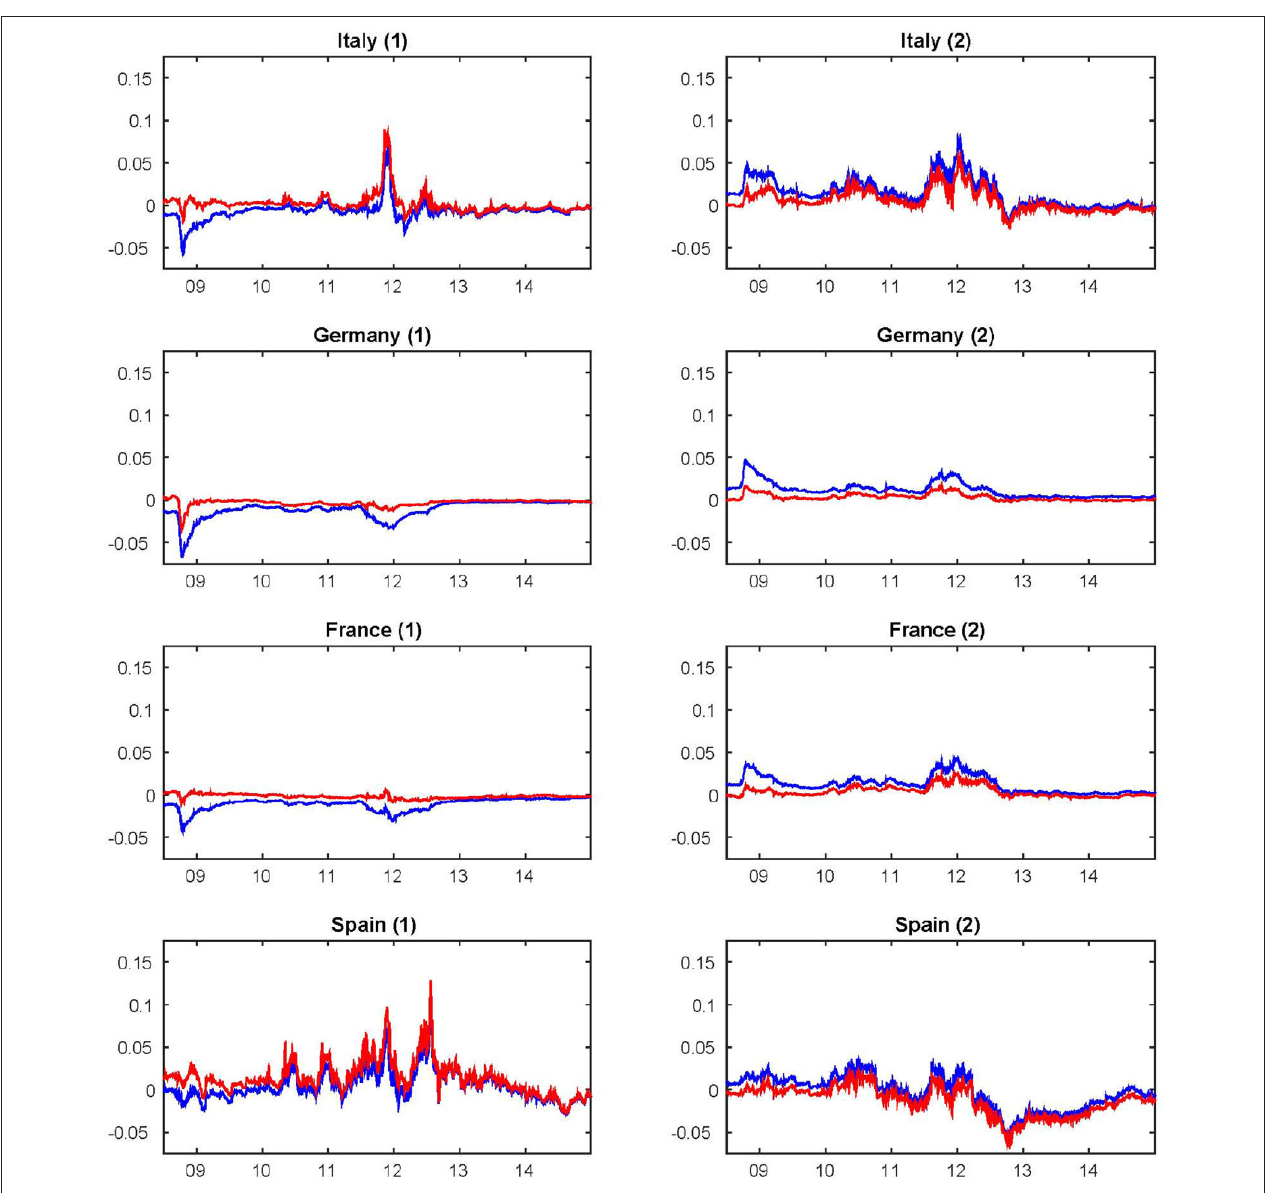
FIGURE 4 | Default intensity processes based the multi-factor model with Vasicek dynamics for the four sovereigns from June 30, 2008 to December 31, 2014. The Kalman filter is considered to extract the unobservable default intensity processes δ t (1) and ξ so V t (2). While in (1) we report the estimation of the factor driving the spread between the sovereign bond yield and the risk-free rate, in (2) we report the estimation of the factor driving the CDS-bond basis. We consider both risk-free Euribor-swap (in blue) and risk-free Eonia (in red) rates as discount factor.